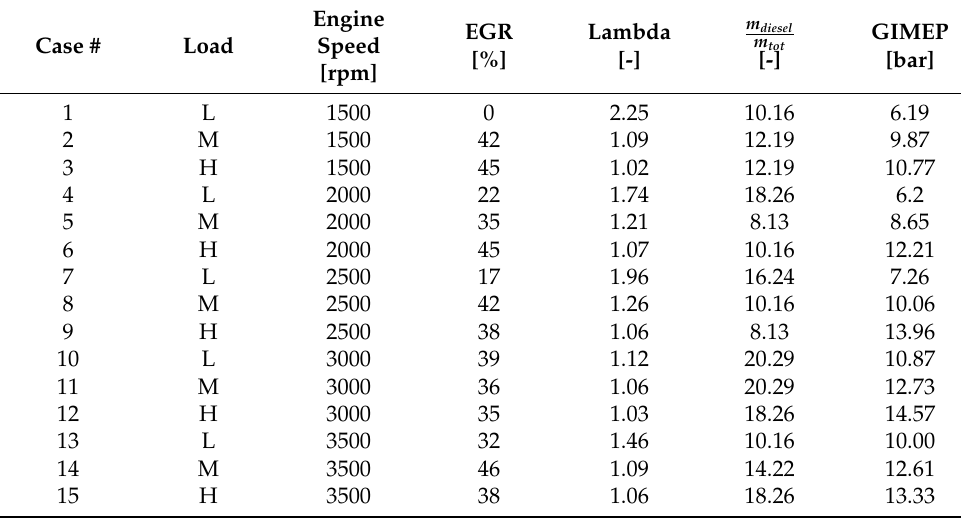
Table 3. Operating conditions of the cylinder running in RCCI mode, selected for the calibration of the GT-Power engine